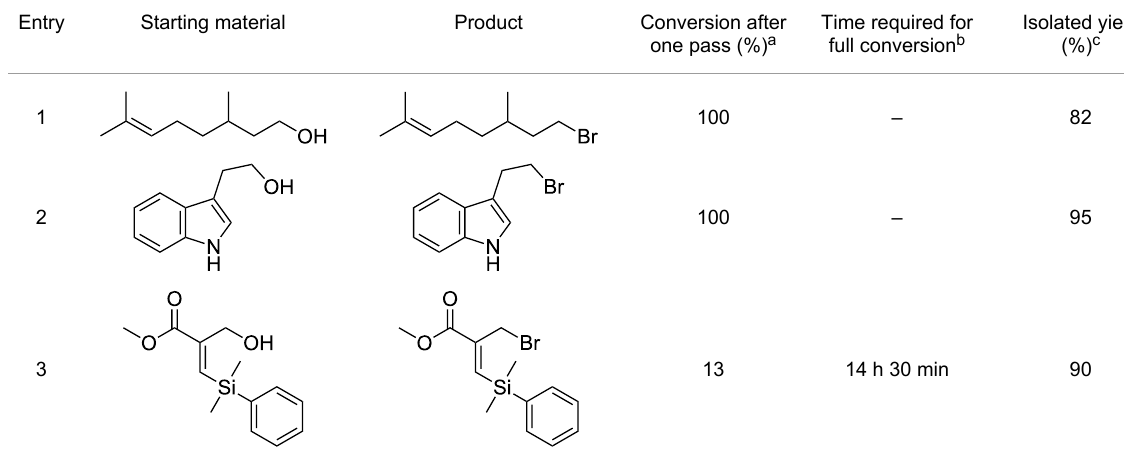
Table 3: Alkyl bromides prepared from the corresponding alcohols using the triphenylphosphine monolith for the Appel reaction in flow.